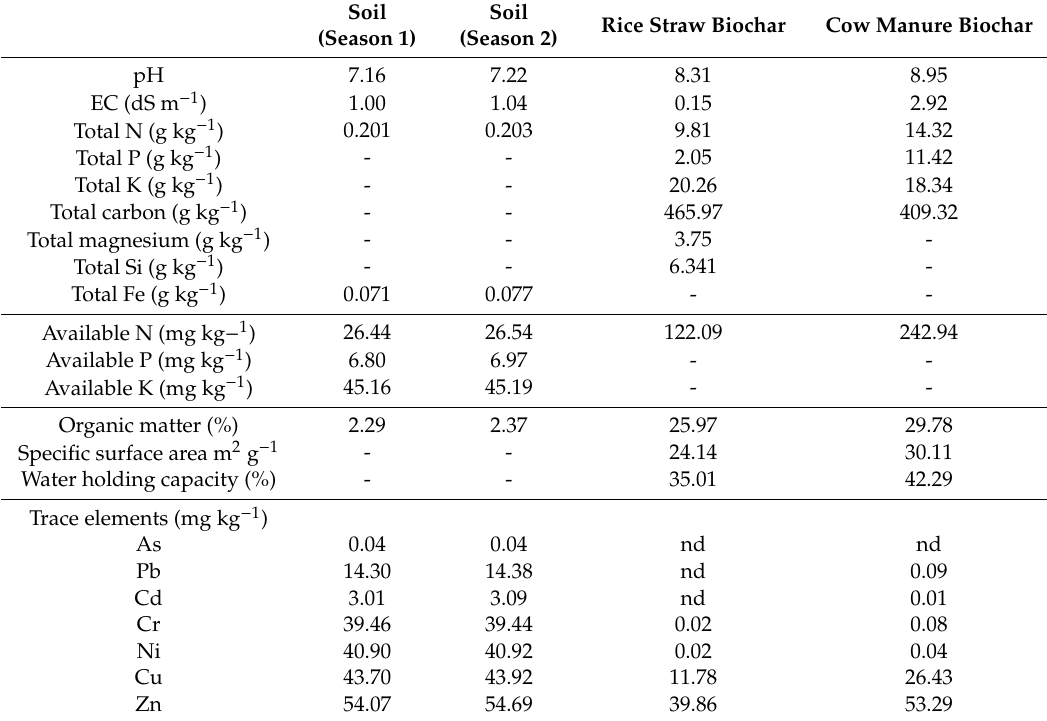
Table 1. Physicochemical characteristics of experimental soil and